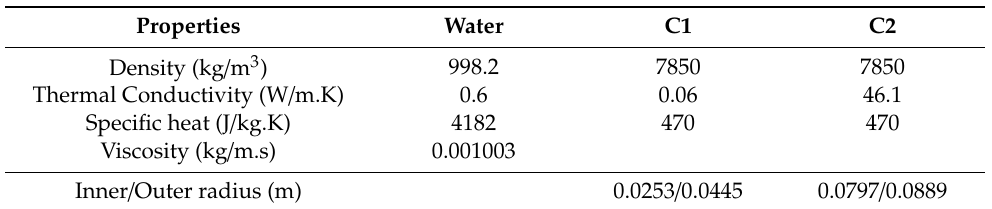
Table 1. Materials constant properties applied for the fluid and well materials. Dimension of the inner casing (C1) and external casing (C2) from